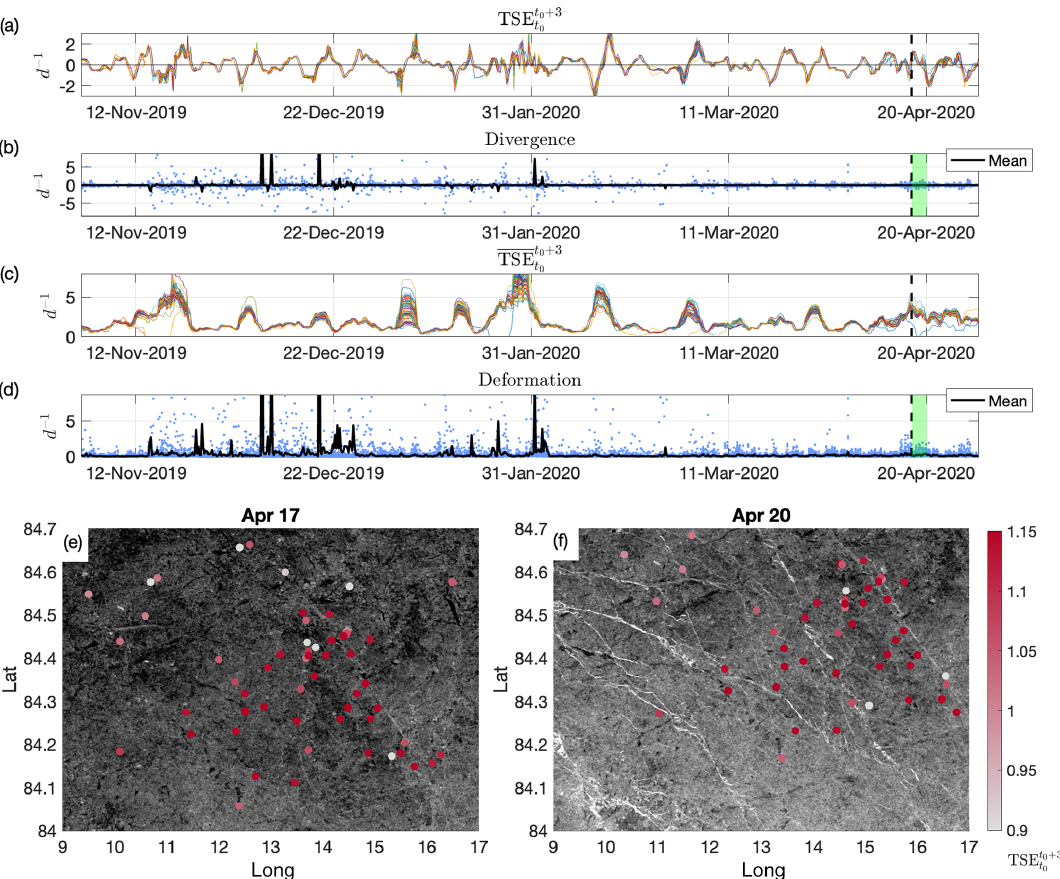
Figure 7. (a–d) Time series comparison of trajectory-stretching exponents and common buoy-array-based approximations of divergence of and total deformation during the MOSAiC expedition. The vertical dashed black lines show a sea ice fracture event that was largely missed in the divergence and deformation. Panels (e) and (f) show a before-and-after comparison of HH Sentinel-1 frames surrounding the 17 April spike. Over this time span, the creation of multiple LKFs in white can be seen, as well as the concurrent TSE values of nearby buoys.